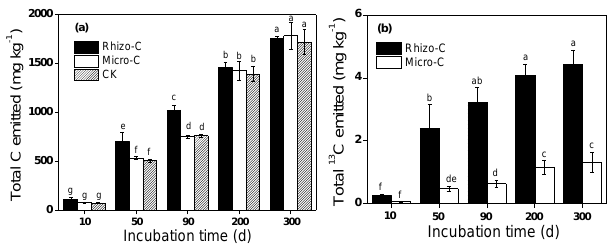
Figure 5. Total C (a) and 13 C (b) emission by 13 C-labelled rhizo- C- and micro-C-accumulated C-treated soils over the 300-day incu- bation period. Values and error bars represent means ± SE ( n = 4). Different letters indicate significant differences at p <0.05 (Dun- can multiple range test). Rhizo-C, paddy soil containing 13 C- labelled rhizodeposits; micro-C, paddy soil containing 13 C-labelled microbe-accumulated C; CK, unlabelled and unplanted soil without